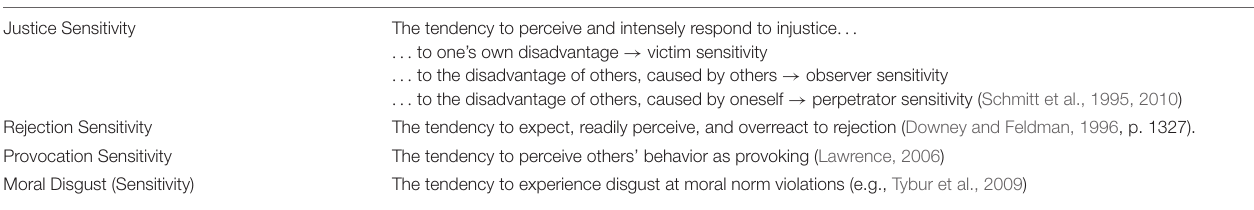
TABLE 1 | Definitions of and overview over the sensitivity measures in the present